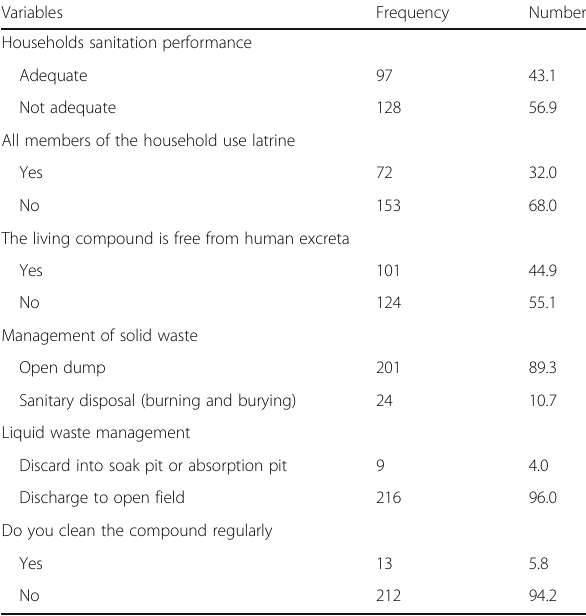
Table 5 Waste management practices of rural households in Dembiya, northwest Ethiopia, May